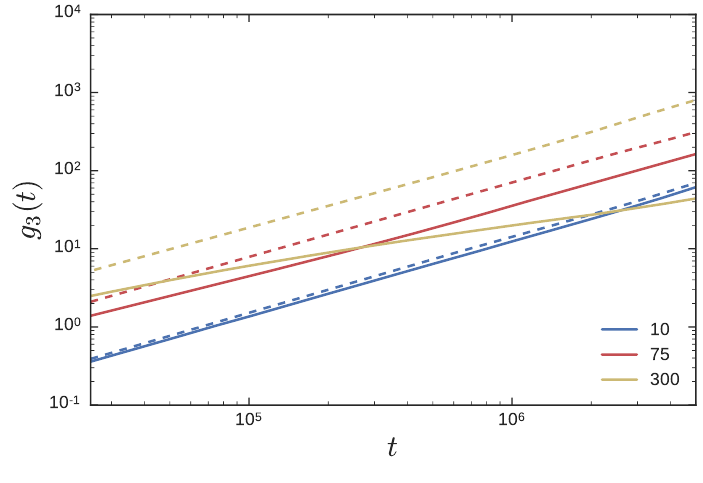
Figure 9. The g 3 ( t ) curves of the probe rings for N l = 10, 75, and 300 for the CX (dashed) and NC simulations (solid) simulations from Figure 8 are plotted